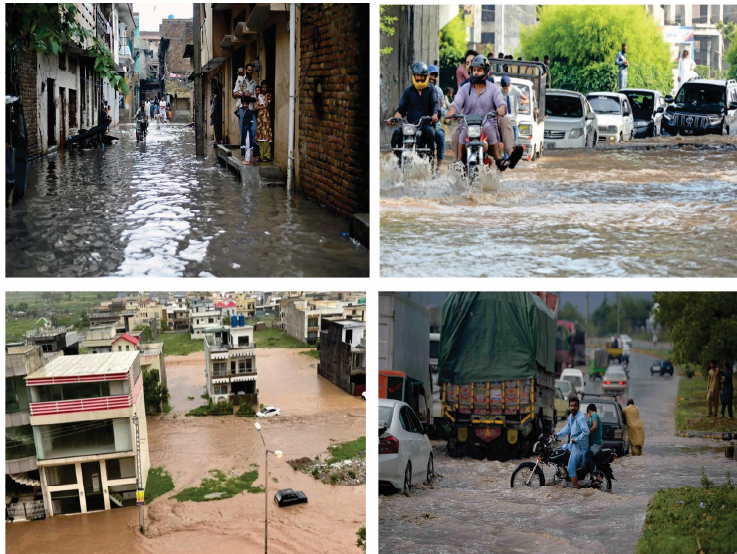
Figure 19. Water on roads in the research area during rain.